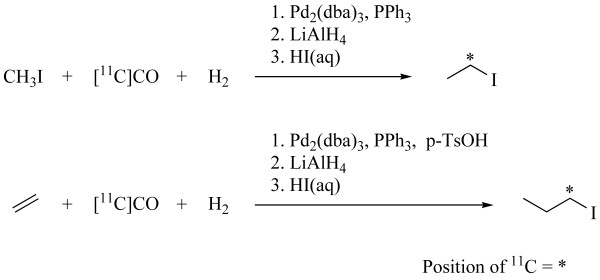
Synthesis of [1-11C]ethyl iodide and [1-11C]propyl iodide.